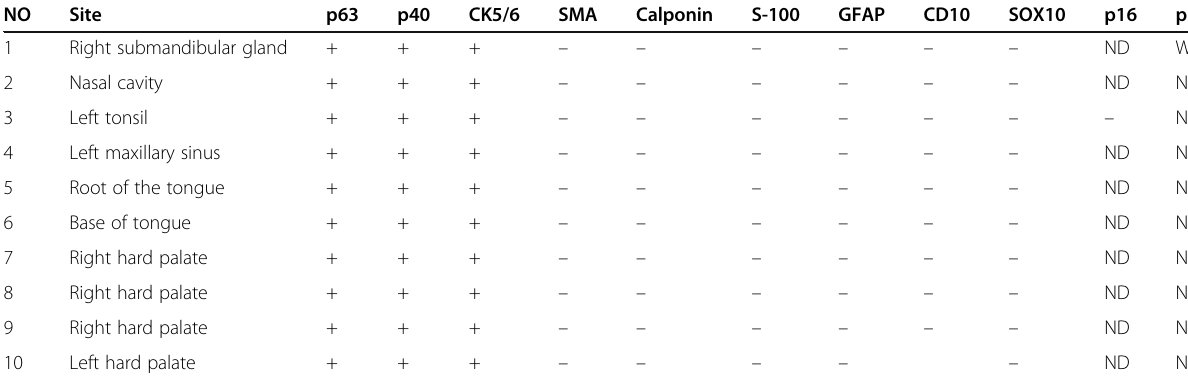
Table 2 IHC detection results in 10 cases of CCC